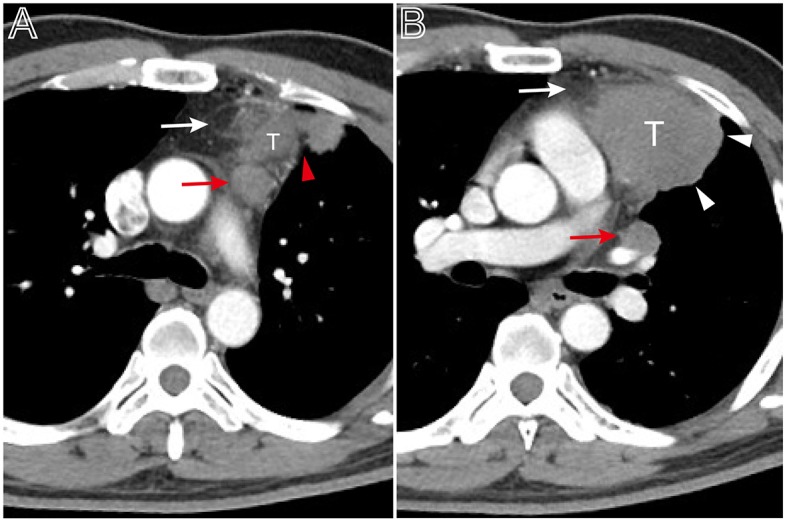
A thymoma with infiltration of surrounding fat and lymph node enlargement. Axial contrast-enhanced chest CT image obtained at the level of the pulmonary trunk demonstrated a thymoma in a 49-year-old man (Masaoka–Koga stage IVb and WHO classification B3). (A,B) Showed the thickened pleura (red arrow head), infiltration of surrounding fat (white arrows), and bulging margin (white arrow head). The lymph node enlargement appeared at the superior level of the lesion (A, red arrow) and at the level of left hilum (B, red arrow).